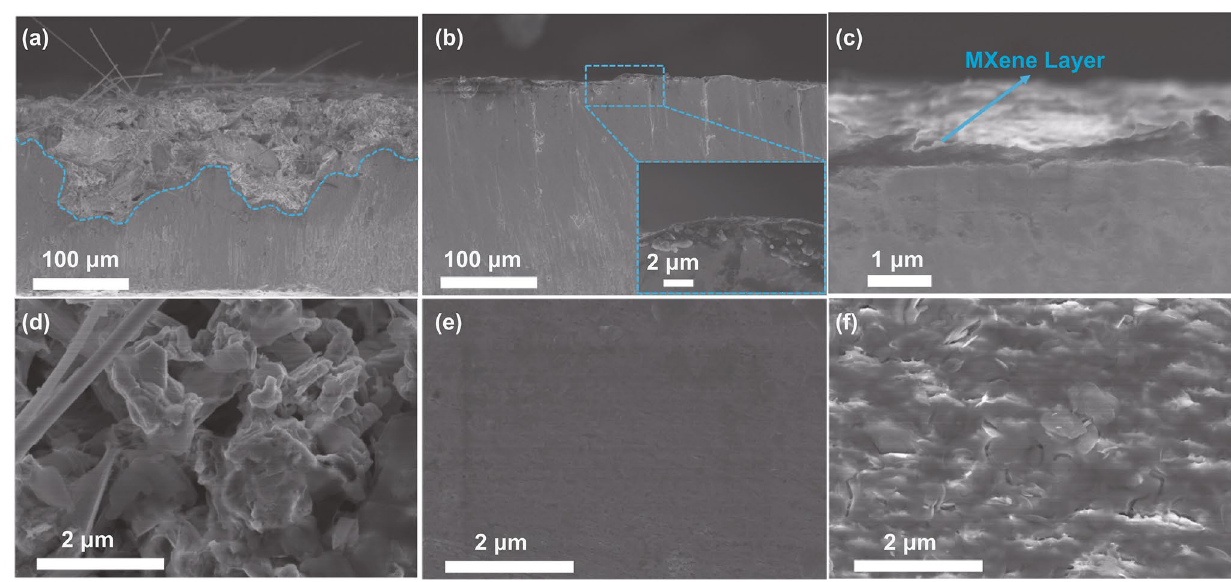
Fig. 4 Cross-sectional and surface configuration of Zn anode after cycling at current density of 2 mA cm −2 with 1 mAh cm −2 Zn plating/strip- ping: a, d in ZSO electrolyte after 50 h, b, e in ZSO-MXene-0.05 electrolyte after 50 h and c, f 400